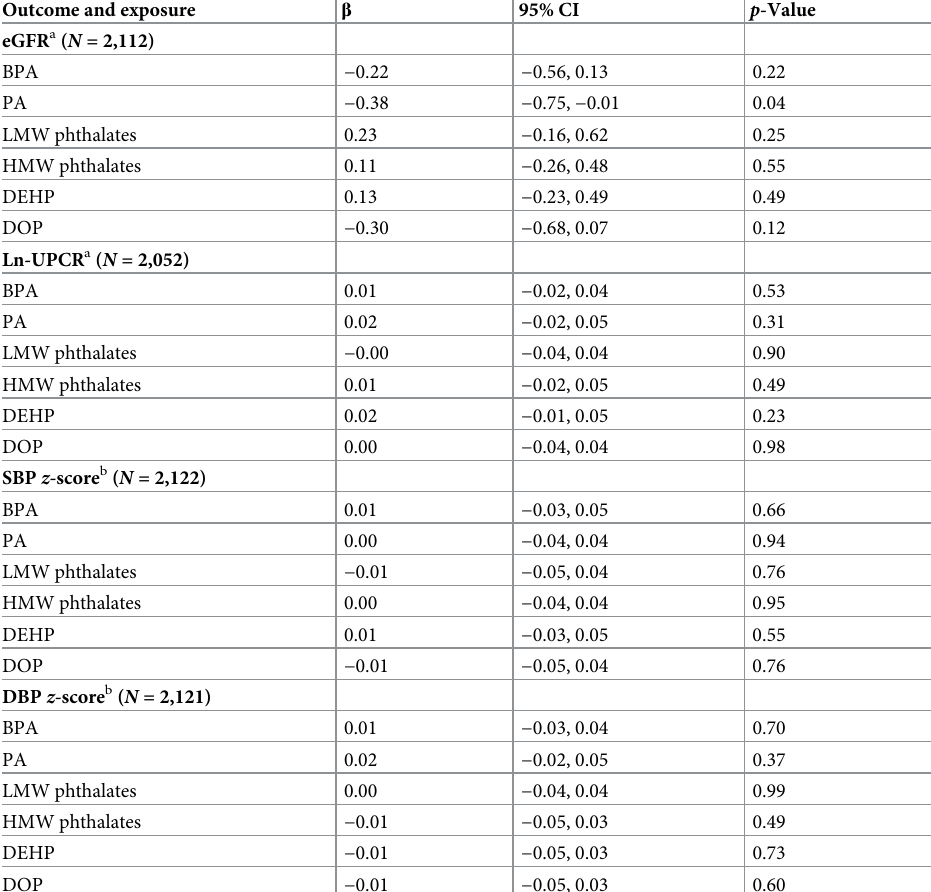
Table 3. Associations between ln-transformed chemical exposures and eGFR, ln-transformed UPCR, SBP z- score, and DBP z- score from linear mixed-effects models. Outcome and exposure β 95% CI